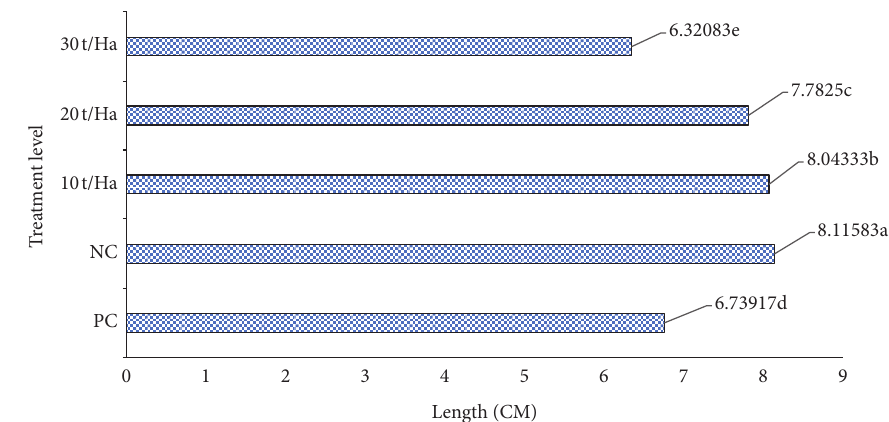
Figure 2: Root length. ∗ Means with different letters are significantly different at p < 0.05. PC � positive control. NC � negative control. t/Ha � spent mushroom rate per hectare.